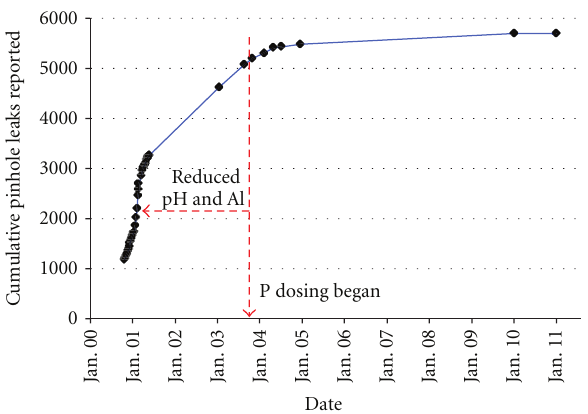
Figure 8: Cumulative volume of reported pinhole leaks to a utility between 2000–2011. Following introduction of phosphate at the water treatment facility, leak reports quickly